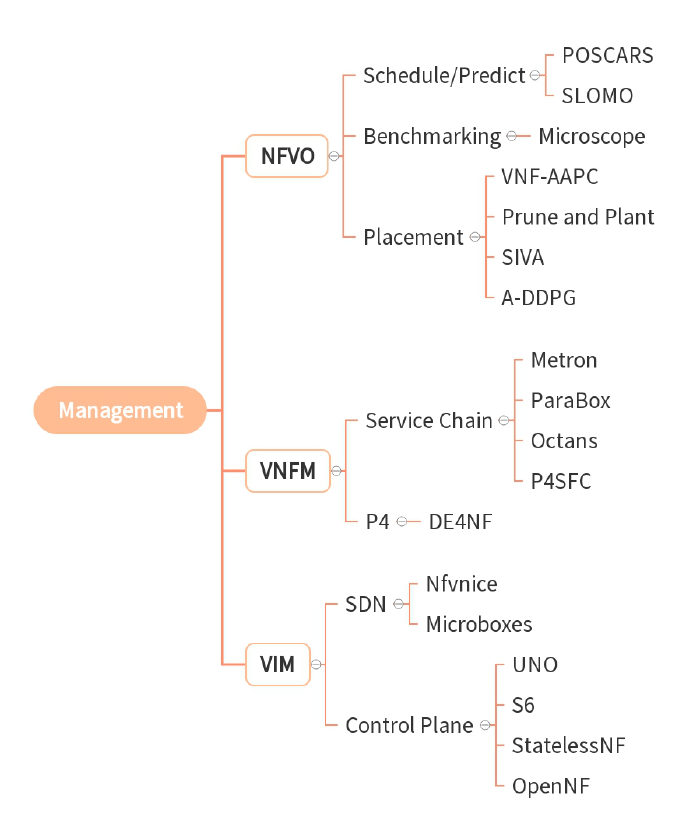
Figure 3. The accelerating solutions based on NFV management